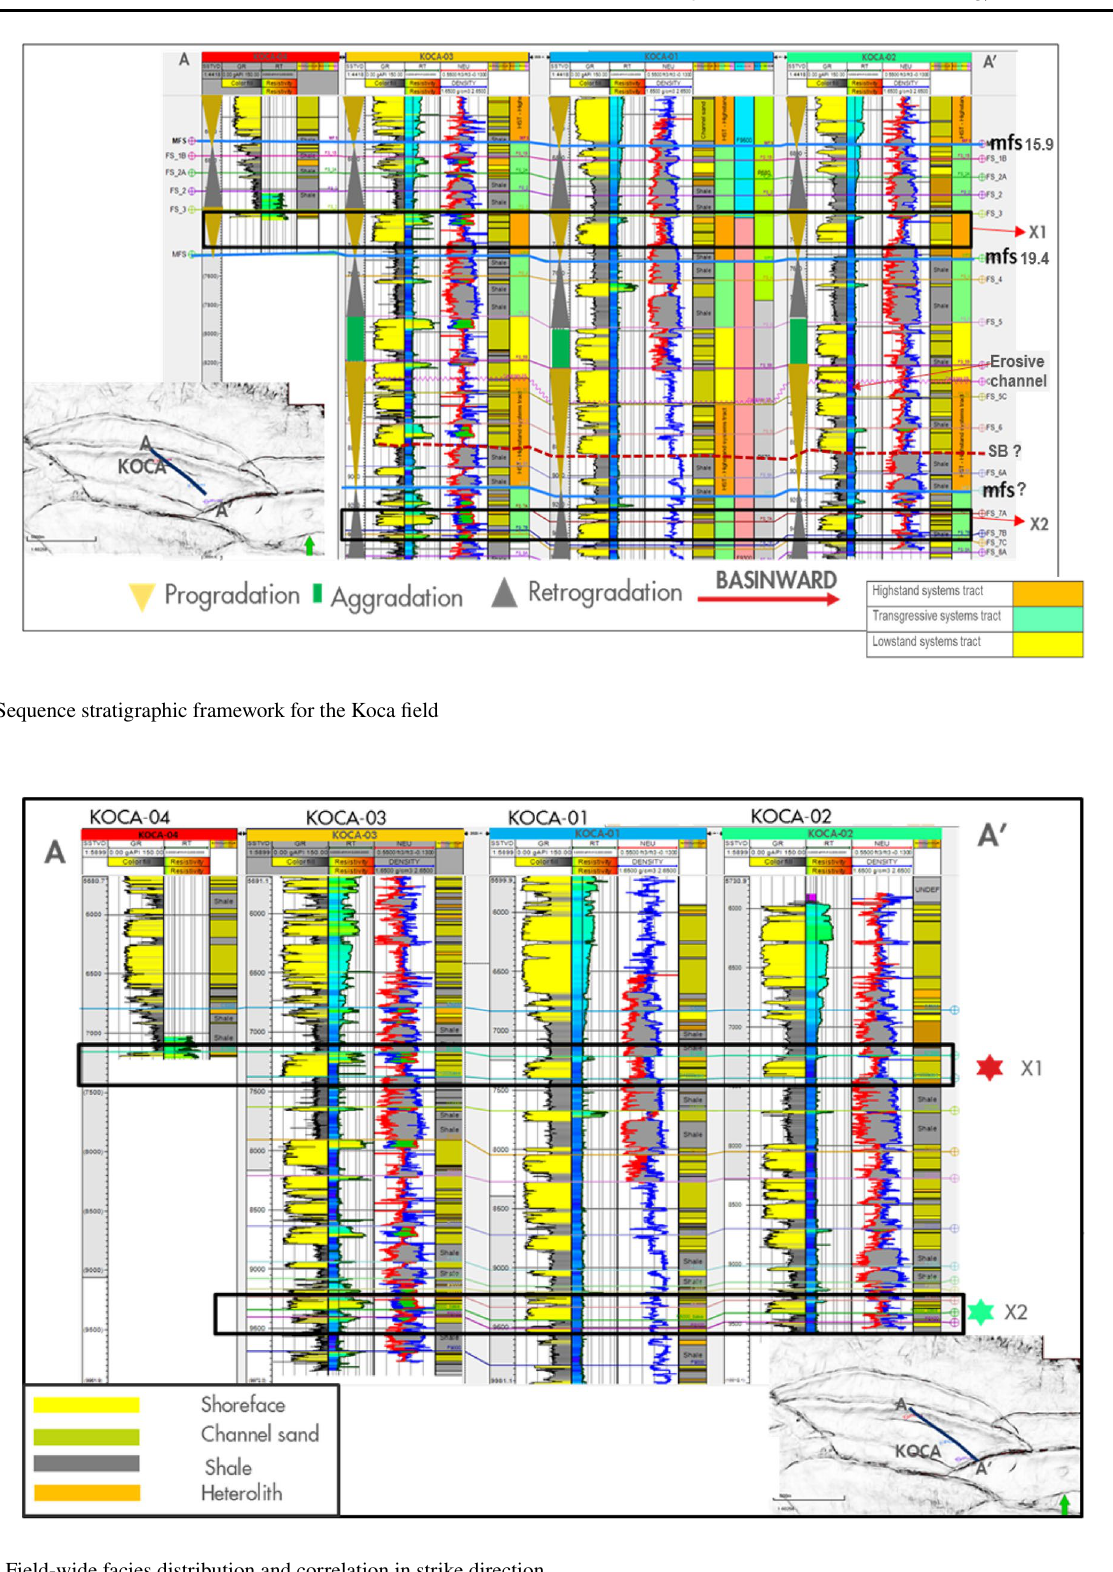
Fig. 10 Field-wide facies distribution and correlation in strike direction